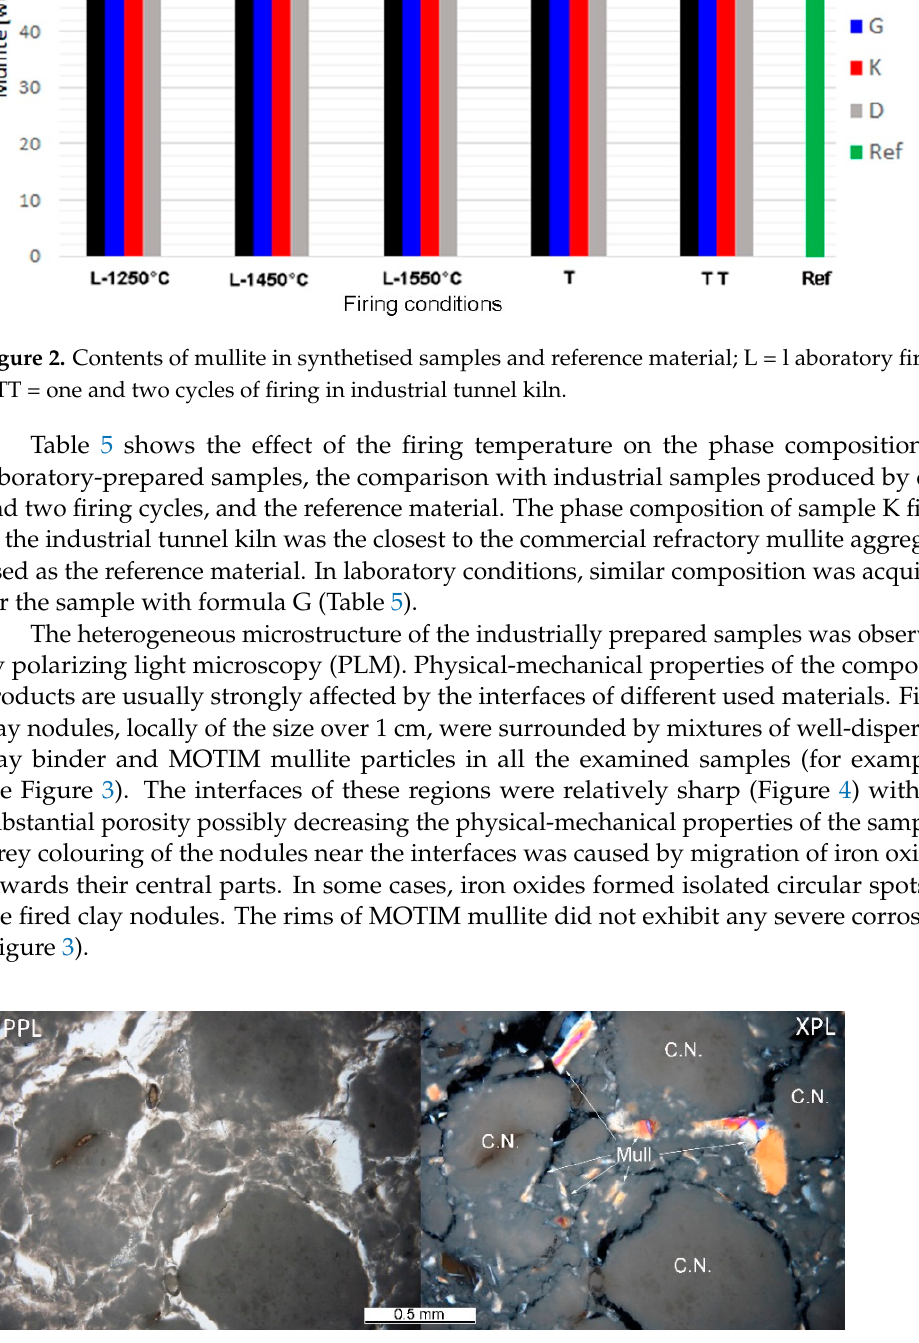
Figure 1. Cristobalite and amorphous phase contents in laboratory-fired samples; no cristobalite was detected in K-L and D-L samples.